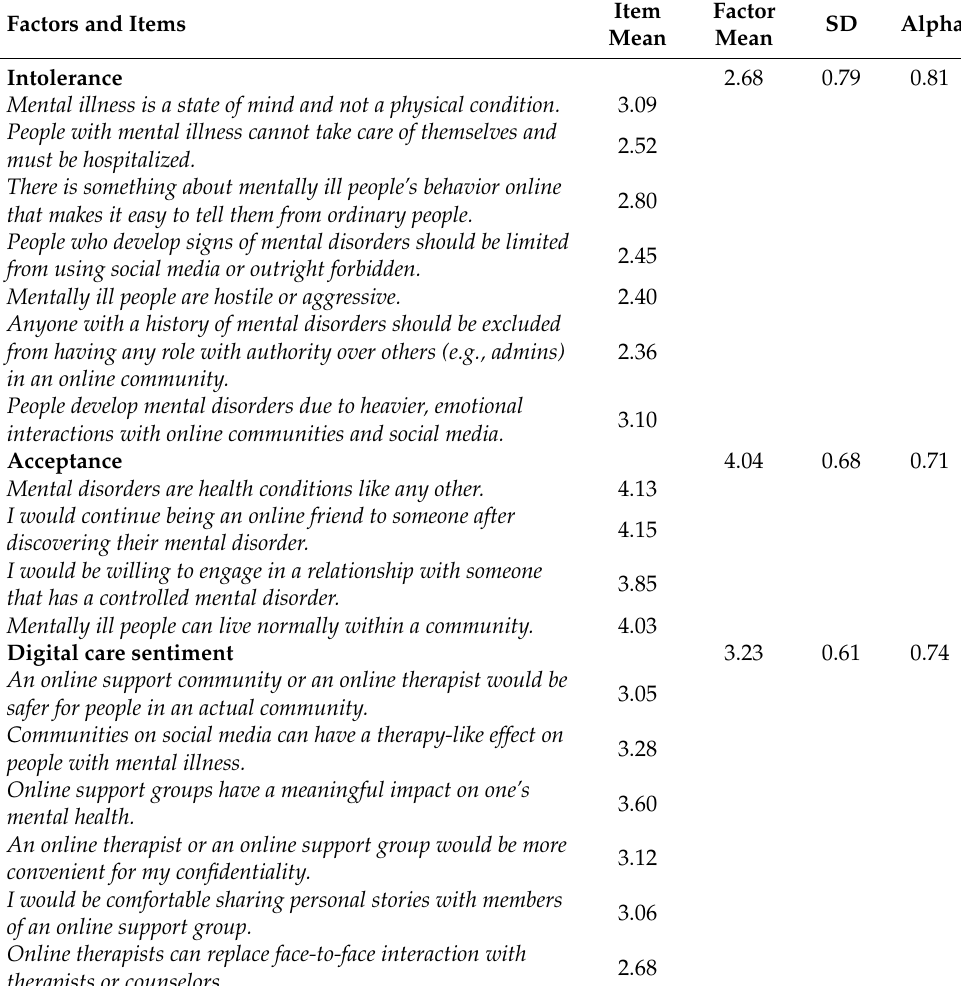
Table 3. Extracted three factors with corresponding items.